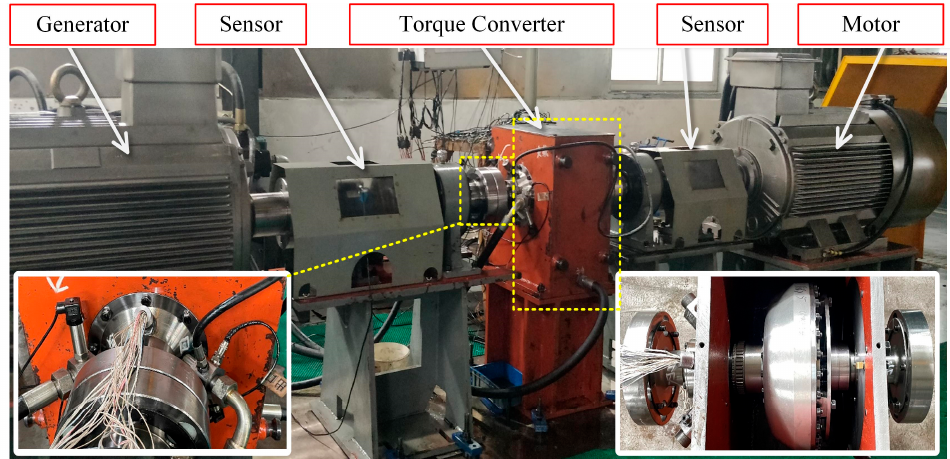
Figure 5. Torque converter test cell and its components.